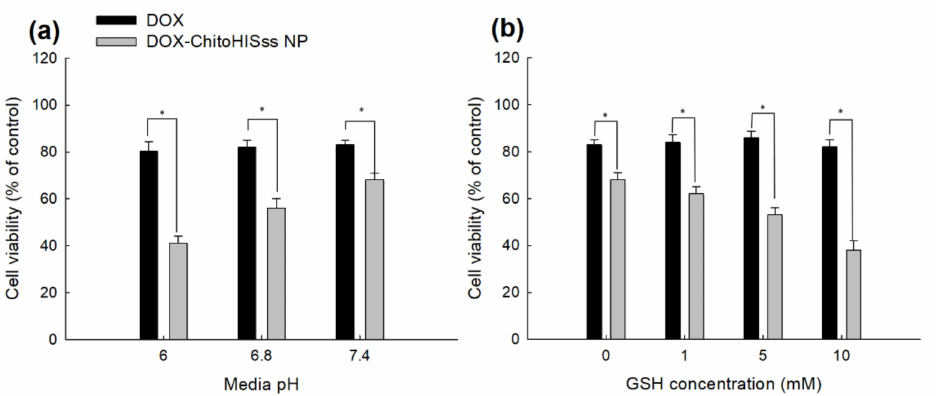
Figure 8. Cell cytotoxicity of DOX and DOX-incorporated ChitoHISss nanoparticles against DOX- resistant HuCC-T1 cells. The effect of media pH ( a ) and the addition of GSH ( b ). For cytotoxicity study, cells were exposed to each pH solution for 6 h and then media were replaced with normal serum-free media. After that, cells were further cultured for 24 h. DOX-ChitoHISss NP: DOX- incorporated ChitoHISss nanoparticles. DOX-concentration: 0.1 µ g/mL. Each measurement was average ± standard deviation (S.D.) from eight wells of 96-well plates. * indicates comparison between DOX and DOX-ChitoHISss NP. ANOVA followed by Tukey test, p < 0.05.